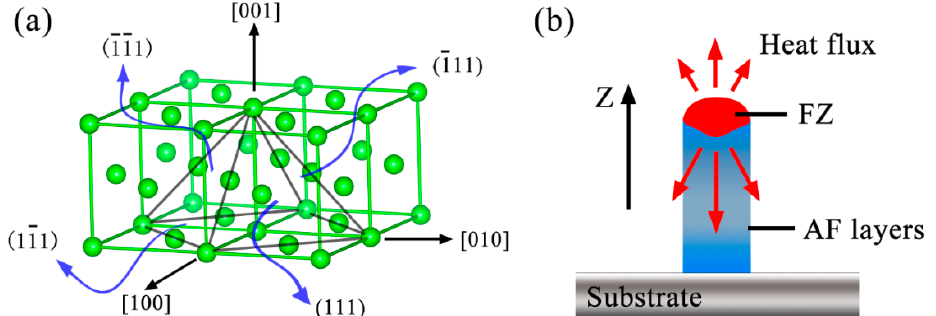
Figure 6. Schematics of ( a ) a pyramid made of four close-packed planes and ( b ) heat dissipation during PPAAM.